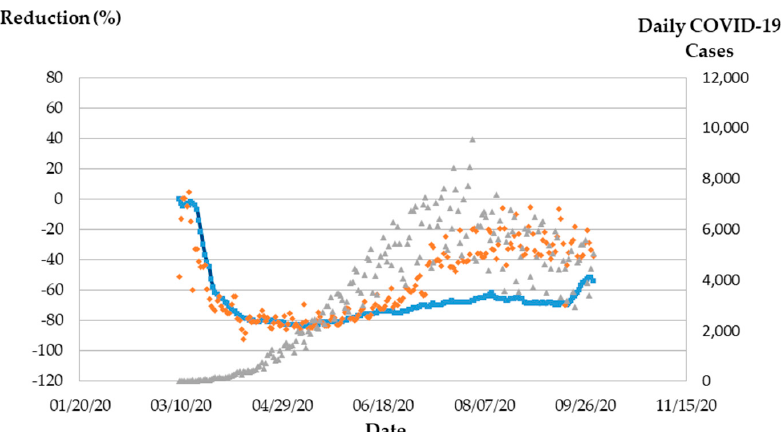
Figure 4. Percentage reduction (%) in traffic congestion (red) and urban transport use (blue), com- pared to the number of daily COVID-19 infections (gray). Mexico City, Mexico.